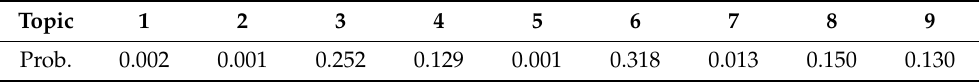
Table 4. Topic probability distribution of the unsegmented review example.